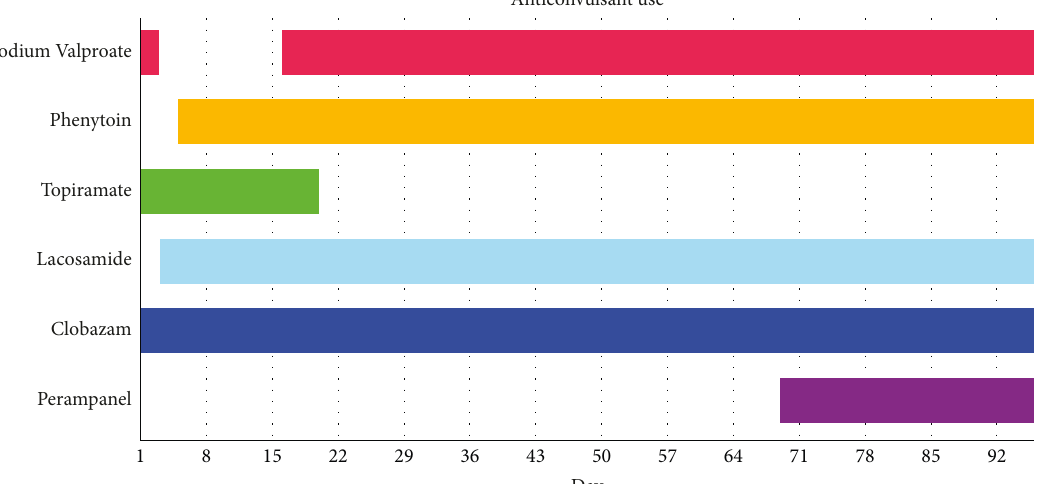
Figure 2: Timeline of various anticonvulsant